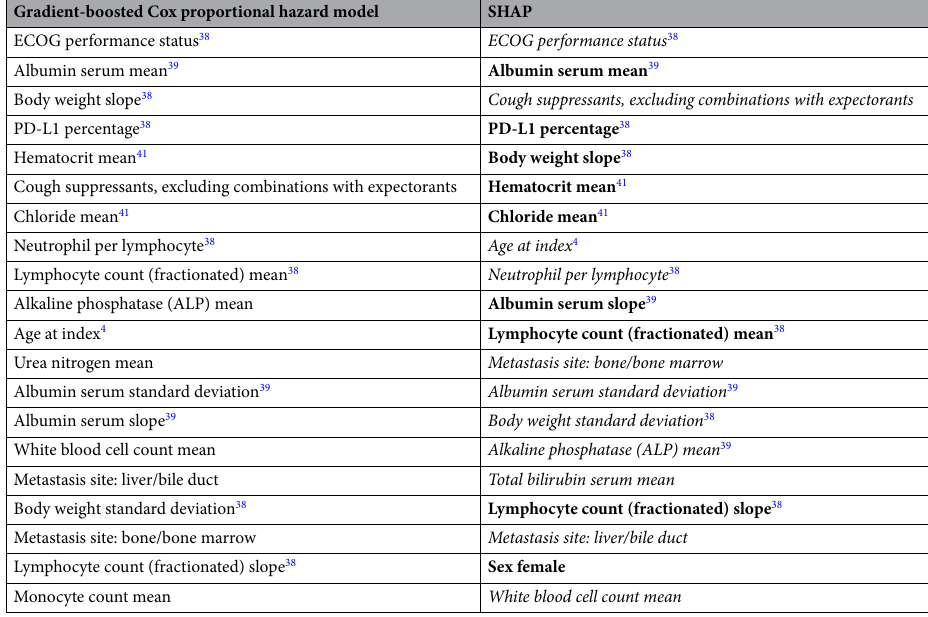
Table 3. Top 20 predictors of overall survival identified by the gradient-boosted Cox proportional hazard model and SHAP values. SHAP indicates directionality of the importance (bold: higher values indicate better overall survival; italics: lower values indicate better overall survival). ECOG, Eastern Cooperative Oncology Group; PD-L1, programmed cell death-ligand 1; SHAP, SHapley Additive exPlanation.